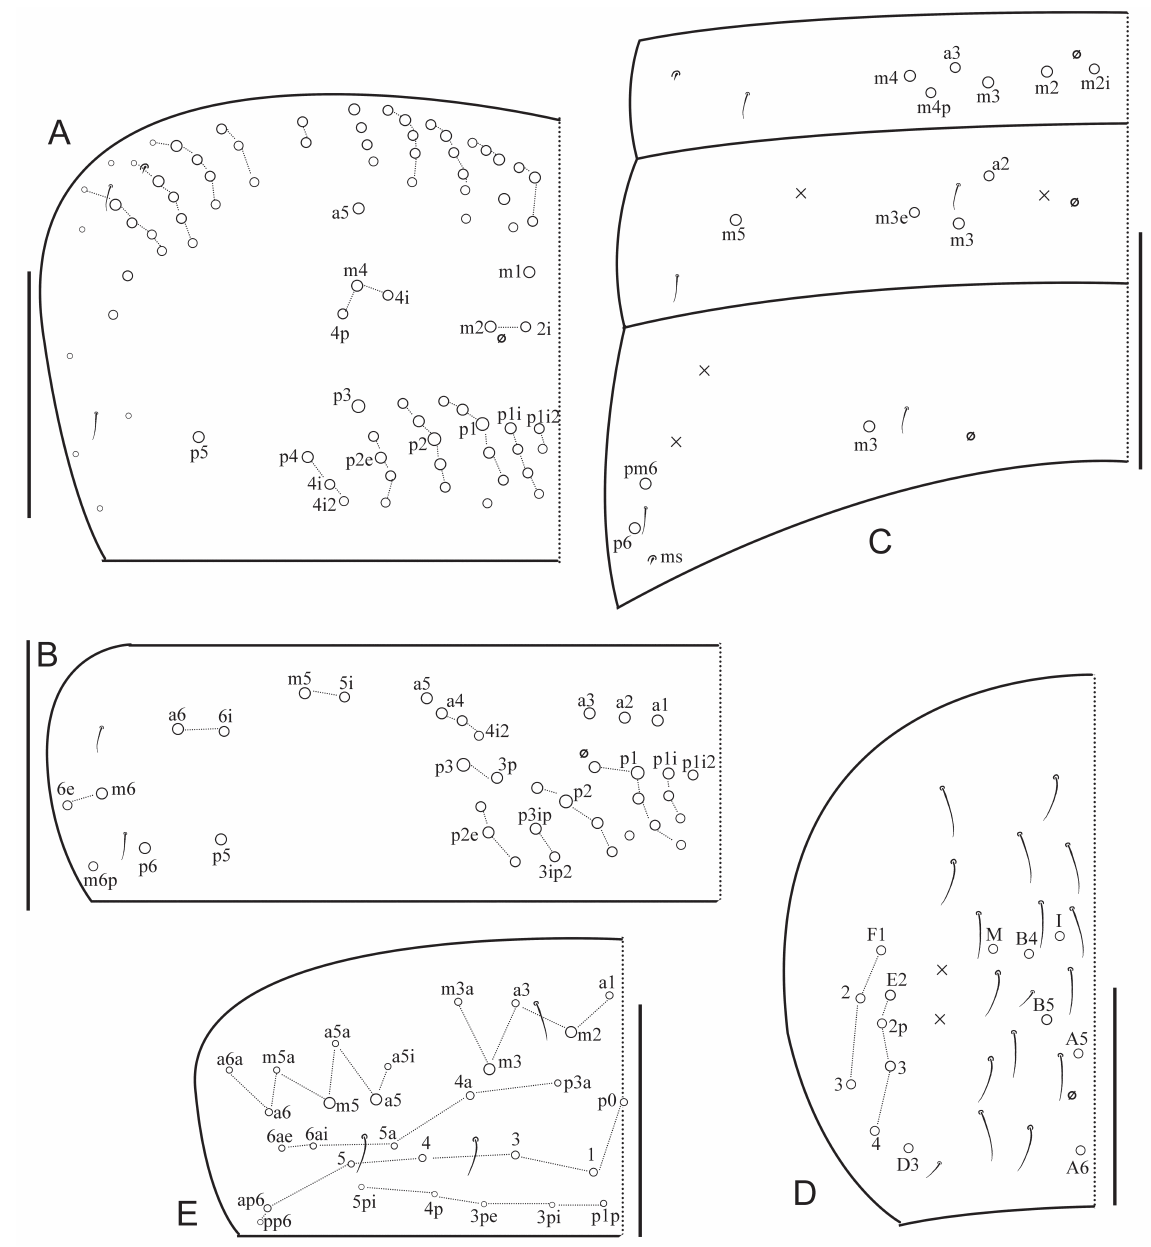
Fig. 5. Coecobrya annulata sp. nov. A . Chaetotaxy of Th. II. B . Chaetotaxy of Th. III. C – E . Abdominal chaetotaxy. C . Abd. I–III. D . Abd. IV. E . Abd. V. Scale bars: 200